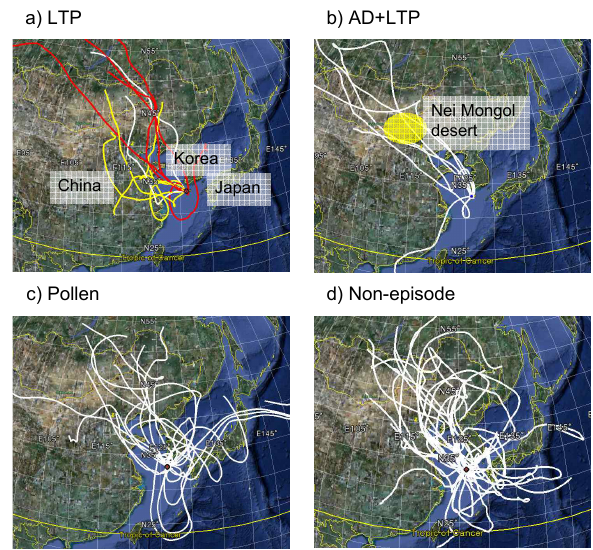
Fig. 4. HYSPLIT air mass backward trajectories arriving at the Gosan site during (a) the LTP, (b) AD+LTP, (c) pollen, and (d) non-episodes. Air mass backward trajectories that ended at the mea- surement site were computed for 500m height above ground level. Yellow trajectories represent the KOS606 and KOS614 sampling periods while red ones represent the KOS621 and KOS623 sam- pling periods. See Table 1 for specifics of each sampling